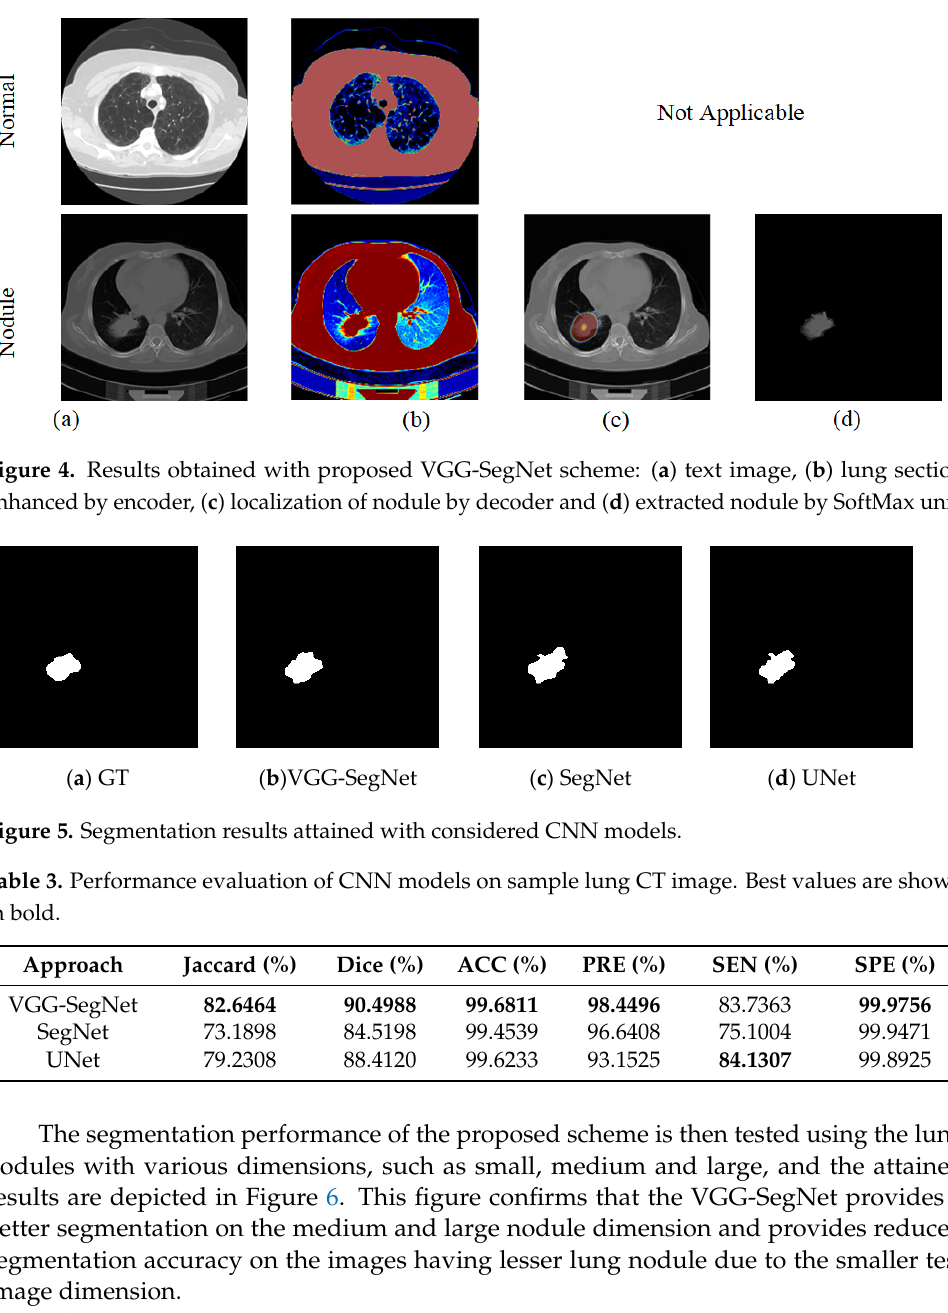
Figure 4. Results obtained with proposed VGG-SegNet scheme: ( a ) text image, ( b ) lung section enhanced by encoder, ( c ) localization of nodule by decoder and ( d ) extracted nodule by SoftMax unit.